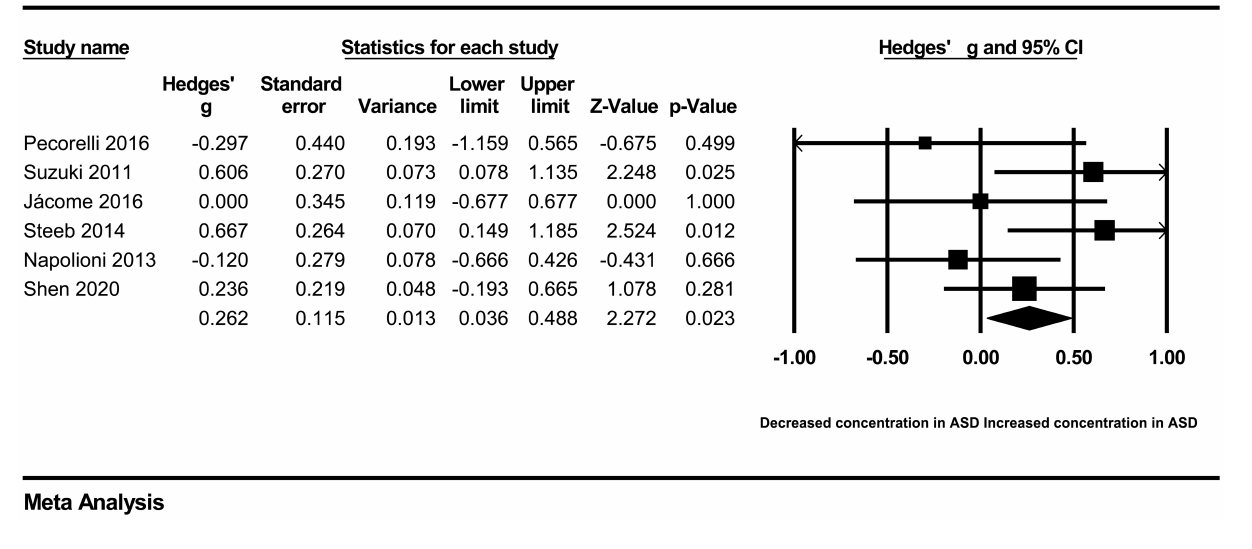
FIGURE 9 | Forest plot for the fixed-effects meta-analysis (IL-7).